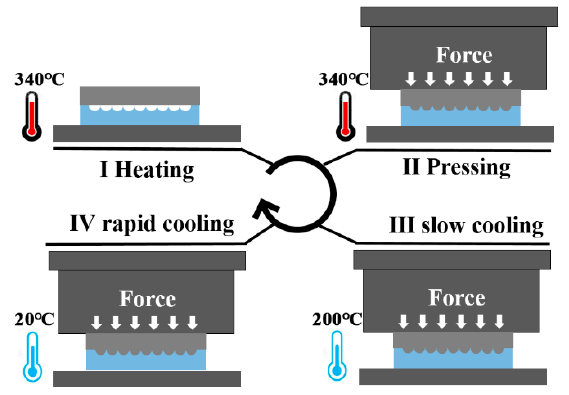
Figure 2. Schematic diagrams of the molding process: I heating, II pressing, III slow cooling, IV rapid cooling.